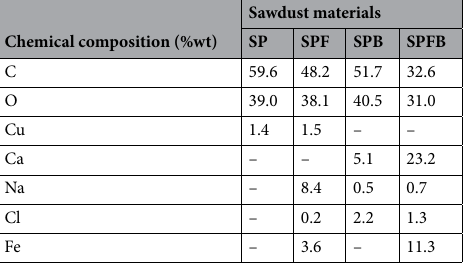
Table 3. The chemical compositions of sawdust powder (SP), sawdust powder doped iron (III) oxide- hydroxide (SPF), sawdust beads (SPB), and sawdust powder doped iron (III) oxide-hydroxide beads (SPFB) in the percentages by